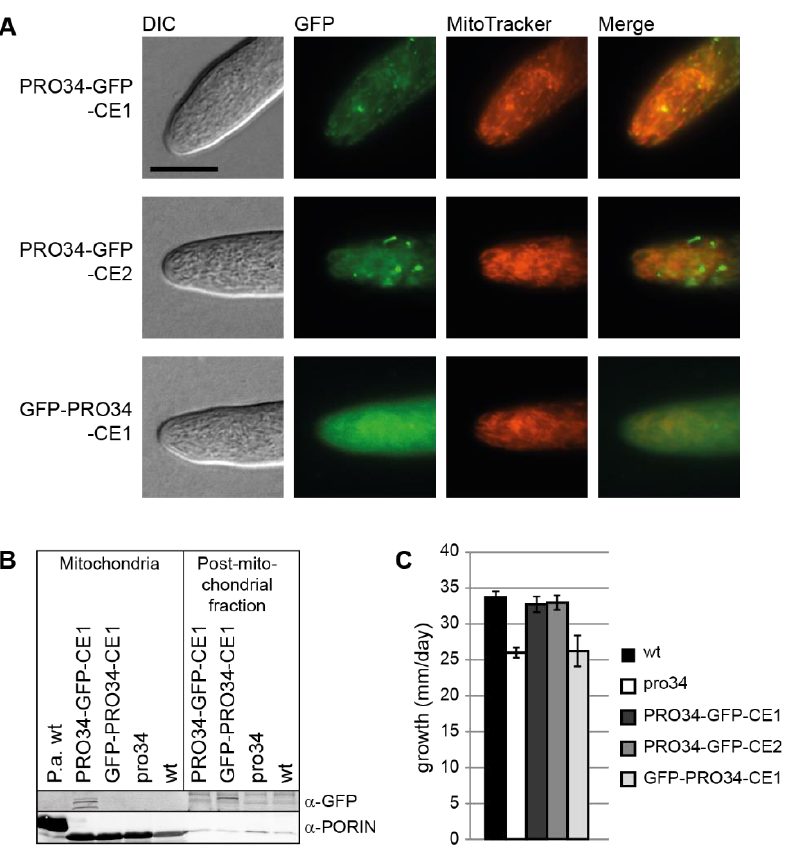
Figure 3. Localization of GFP-tagged PRO34 and vegetative growth. ( A ) The pro34 gene was fused to gfp and expressed from the A. nidulans gpd promoter in the pro34 background. PRO34-GFP localizes to mitochondria, while a strain with N-terminally tagged PRO34 shows additional cytoplasmic fluorescence background. Scale bar, 10 µm. ( B ) Western blot analysis of GFP-tagged PRO34 in mitochondrial and post-mitochondrial fractions. C-terminally GFP-tagged PRO34 is detected in the mitochondrial fraction (PRO34-GFP-CE1), while N-terminally GFP-tagged PRO34 (GFP-PRO34-CE1) is not. Anti-PORIN antibody against P. anserina PORIN was used as a control for mitochondrial localization. P. anserina wild type was used as a control strain. ( C ) Vegetative growth is reduced in pro34 and in GFP-PRO34-CE1. Strains were grown on BMM and growth was measured in a 24h-interval. Data are mean and standard deviation from two biological replicates with two technical replicates